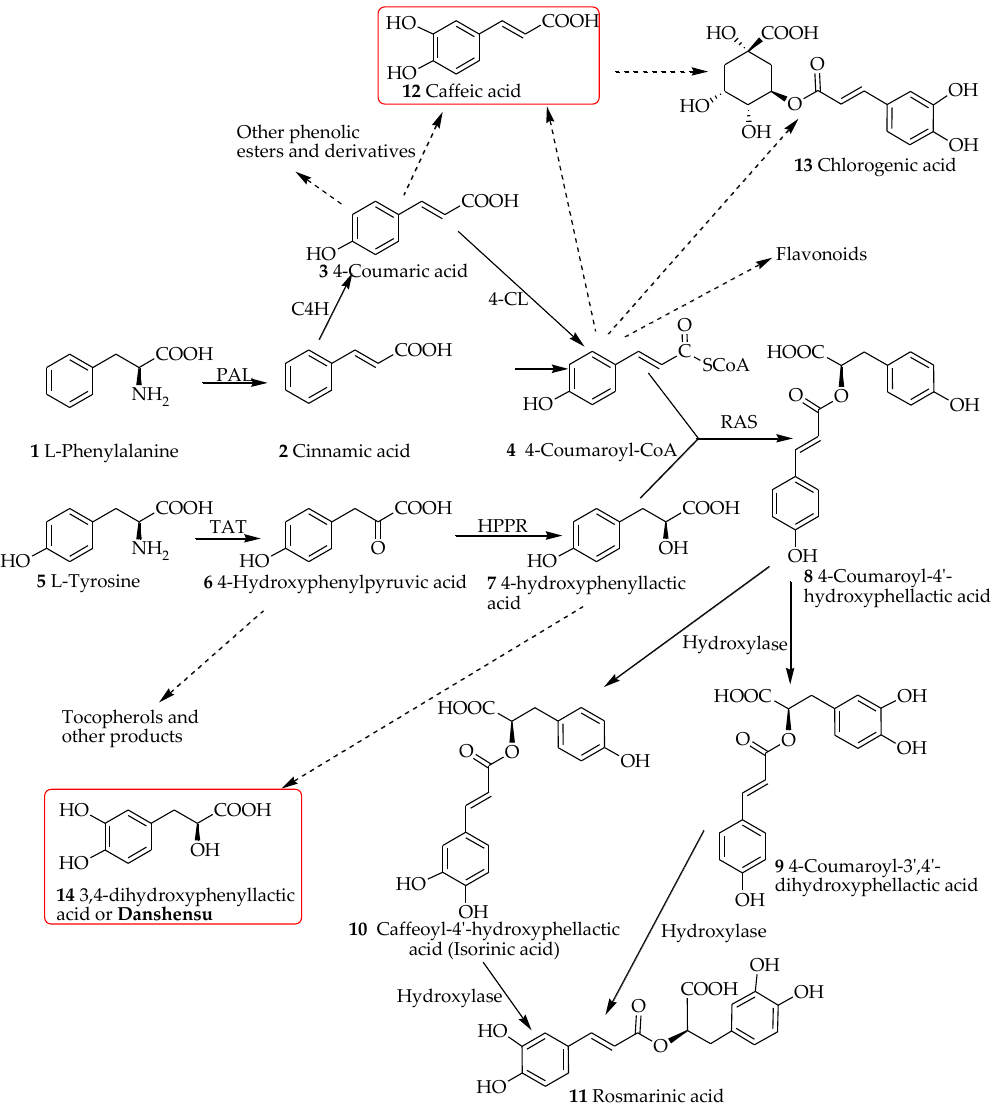
Figure 1. Overview of the biosynthesis pathway of rosmarinic acid and related compounds in plants. 4CL, hydroxycinnamate (or 4-coumaric acid) coenzyme A ligase; C4H, cinnamic acid 4-hydroxylase; HPPR, hydroxyphenylpyruvate reductase; PAL, phenylalanine ammonia-lyase; RAS, rosmarinic acid synthase; TAT, tyrosine aminotransferase. Compounds highlighted by red box are precursors of the salvianolic acids. Dashed arrows represent multi-step reactions.